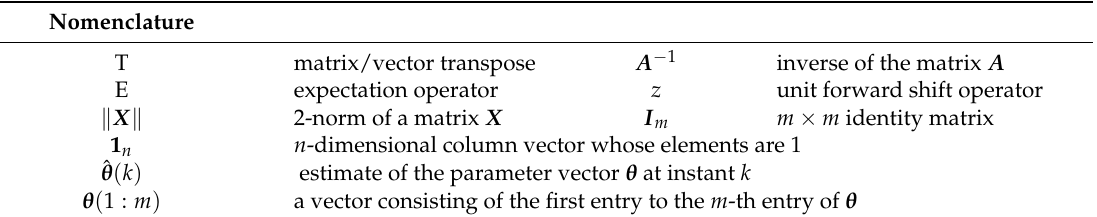
Table 1. The nomenclature for